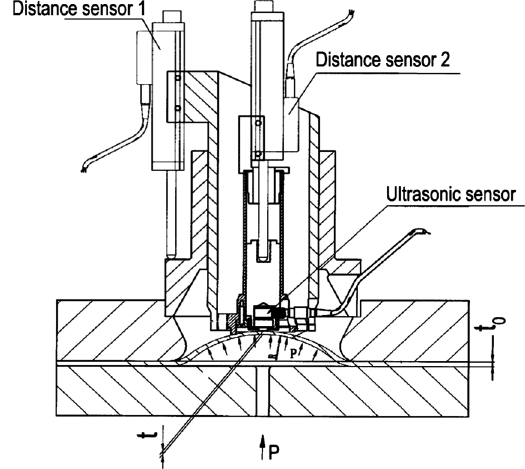
FIG. 8. Scheme of the bulge test device.